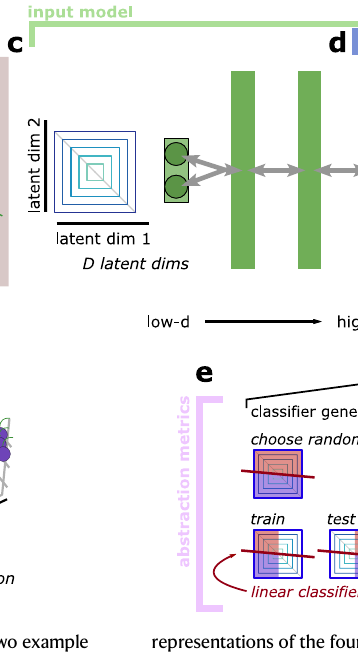
representations of the four example berries. c Schematic of the input model. d Schematic of the multi-tasking model. e Schematic of our two abstraction metrics, the classi fi er generalization metric (left) and the regression generalization metric